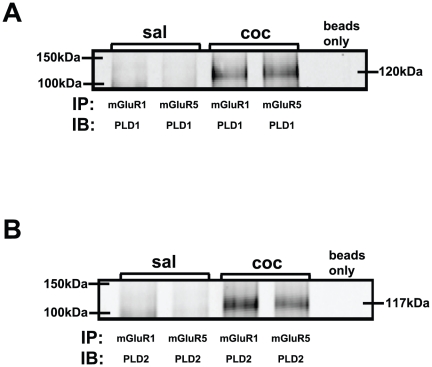
Amygdala protein subjected to co-immunoprecipitation (IP) with mGluR1, mGluR5 and subsequently immunoblotted (IB) with PLD antibodies show association between PLD1/2 and mGluRs1/5 in the cocaine CPP group.A) PLD1 and B) PLD2 were detected only in the amygdala of cocaine CPP group (coc) but not saline-treated group (sal).